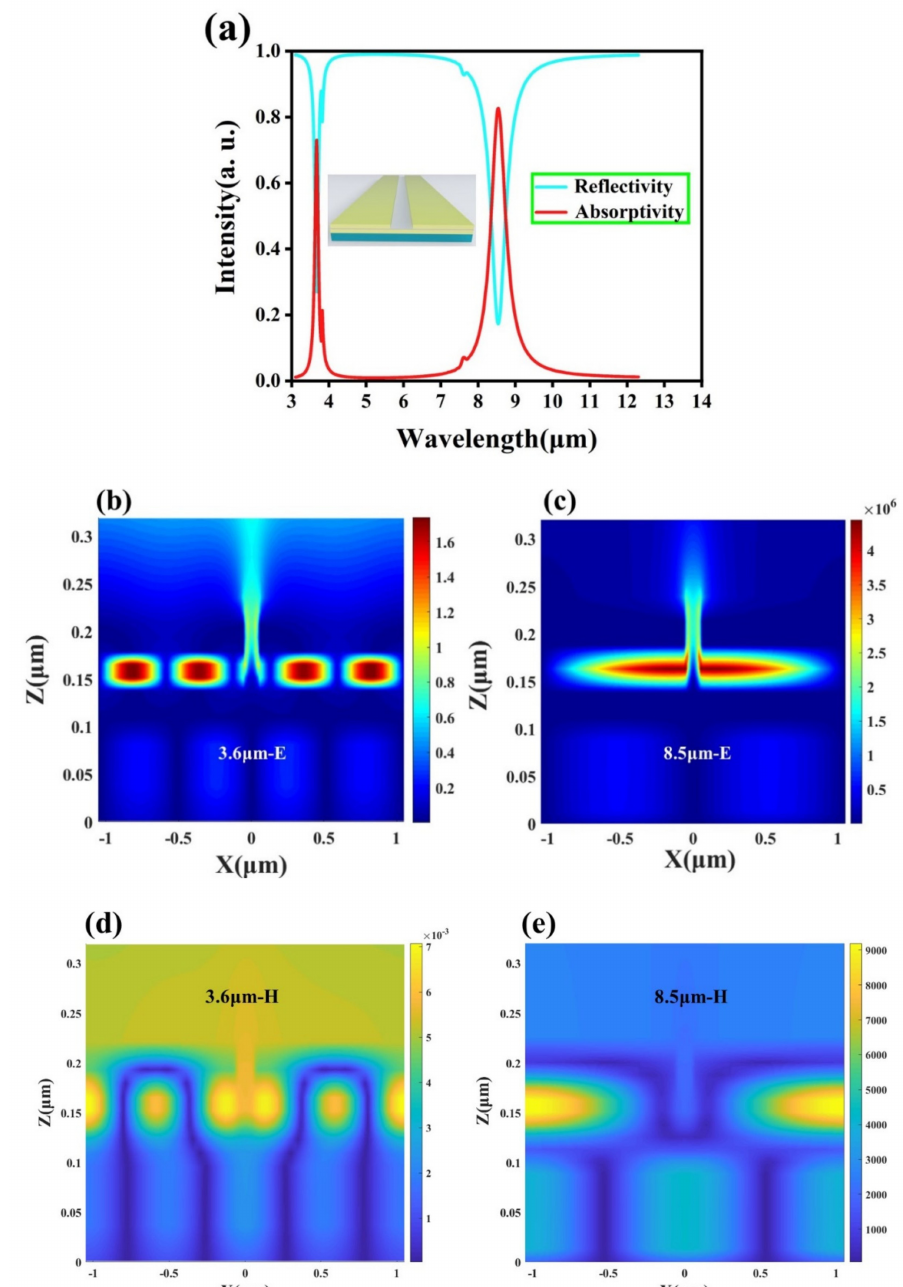
Figure 3. ( a ) Absorption and reflection spectra of the proposed four-layer structure in the infrared band. ( b ) Electric and ( d ) magnetic distributions at the first absorption peak. ( c ) Electric and ( e ) magnetic distributions at the second absorption